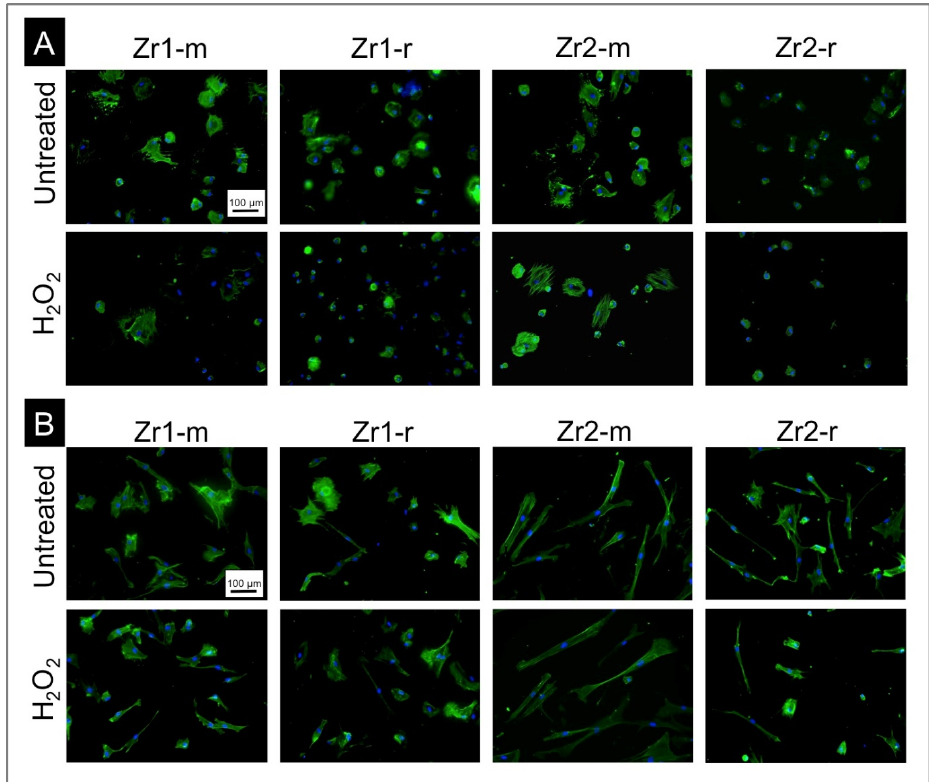
Figure 3. (A , B ) Initial attachment and spread of AO 4 h ( A ) and 24 h ( B ) after seeding onto untreated and H 2 O 2 -treated zirconia surfaces. Representative fluorescence microscopy images of cell cultures with dual staining of DAPI for nuclei (blue) and phalloidin for actin filaments (green) are shown. The quantitative morphometric analysis of the cell area revealed that osteoblasts on With respect to the number of attached cells, the DNA quantification demonstrated Zr1-r displayed lower cell area values than on corresponding untreated surfaces at 4 h ( p < 0.05), and that osteoblasts on Zr2-r showed lower cell area values on H 2 O 2 -treated surfaces compared to untreated surfaces after 24 h ( p < 0.05). No significant differences were detected within the other groups ( p > 0.05) (Figure